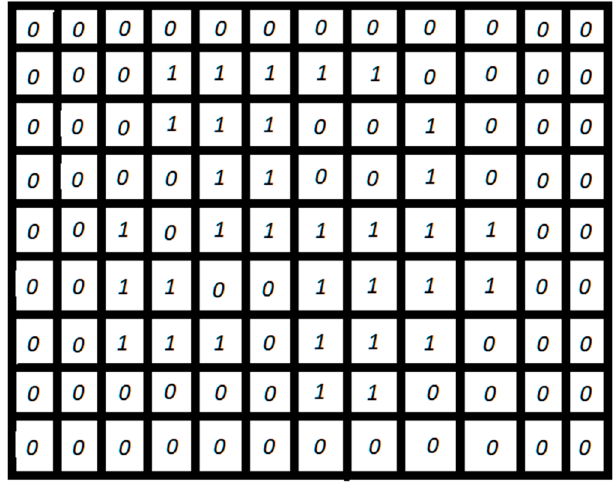
Figure 1. An abstract representation of data that are received by a sensory organ, such as light rays that are absorbed by cells along the surface of the retina of a camera eye. The drawing shows the spatial pattern, but there is also a temporal dimension since this sensory input data are changing over time.